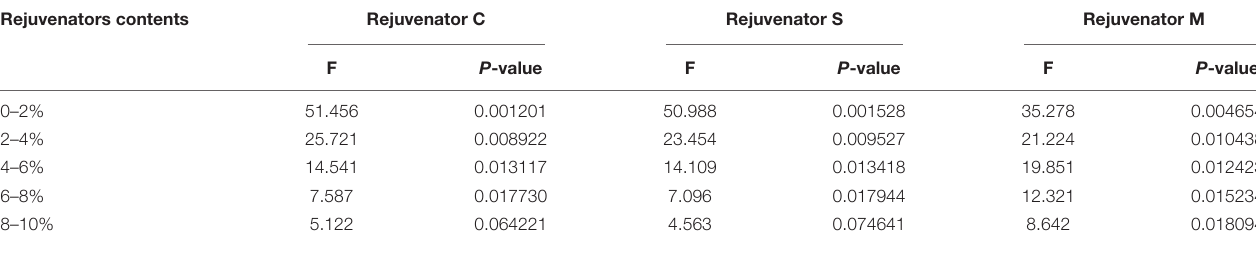
TABLE 11 | One-factor ANOVA on low temperature stiffness of recovered bitumen ( α =